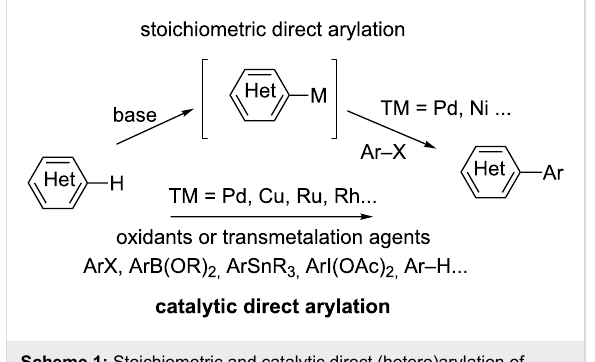
Scheme 1: Stoichiometric and catalytic direct (hetero)arylation of